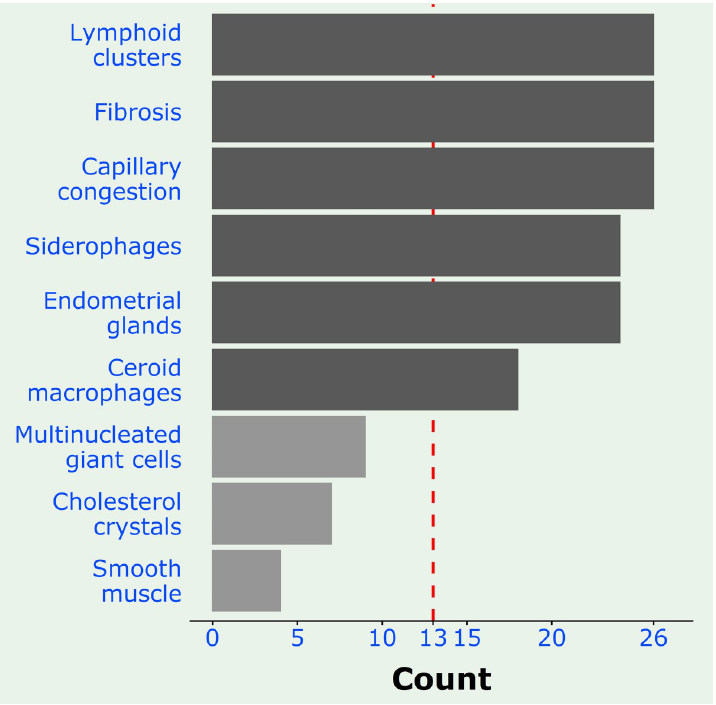
Fig 2. Barplot showing the frequency distribution of the various histological features in the test (thoracic endometriosis) population. The stripped red line marks the point of separation between the frequent or Group A features (darker bars) affecting more than 13 ( > 13/26; 50%) patients from the features (lighter bars) affecting less than 13 ( < 13/26; 50%) patients.